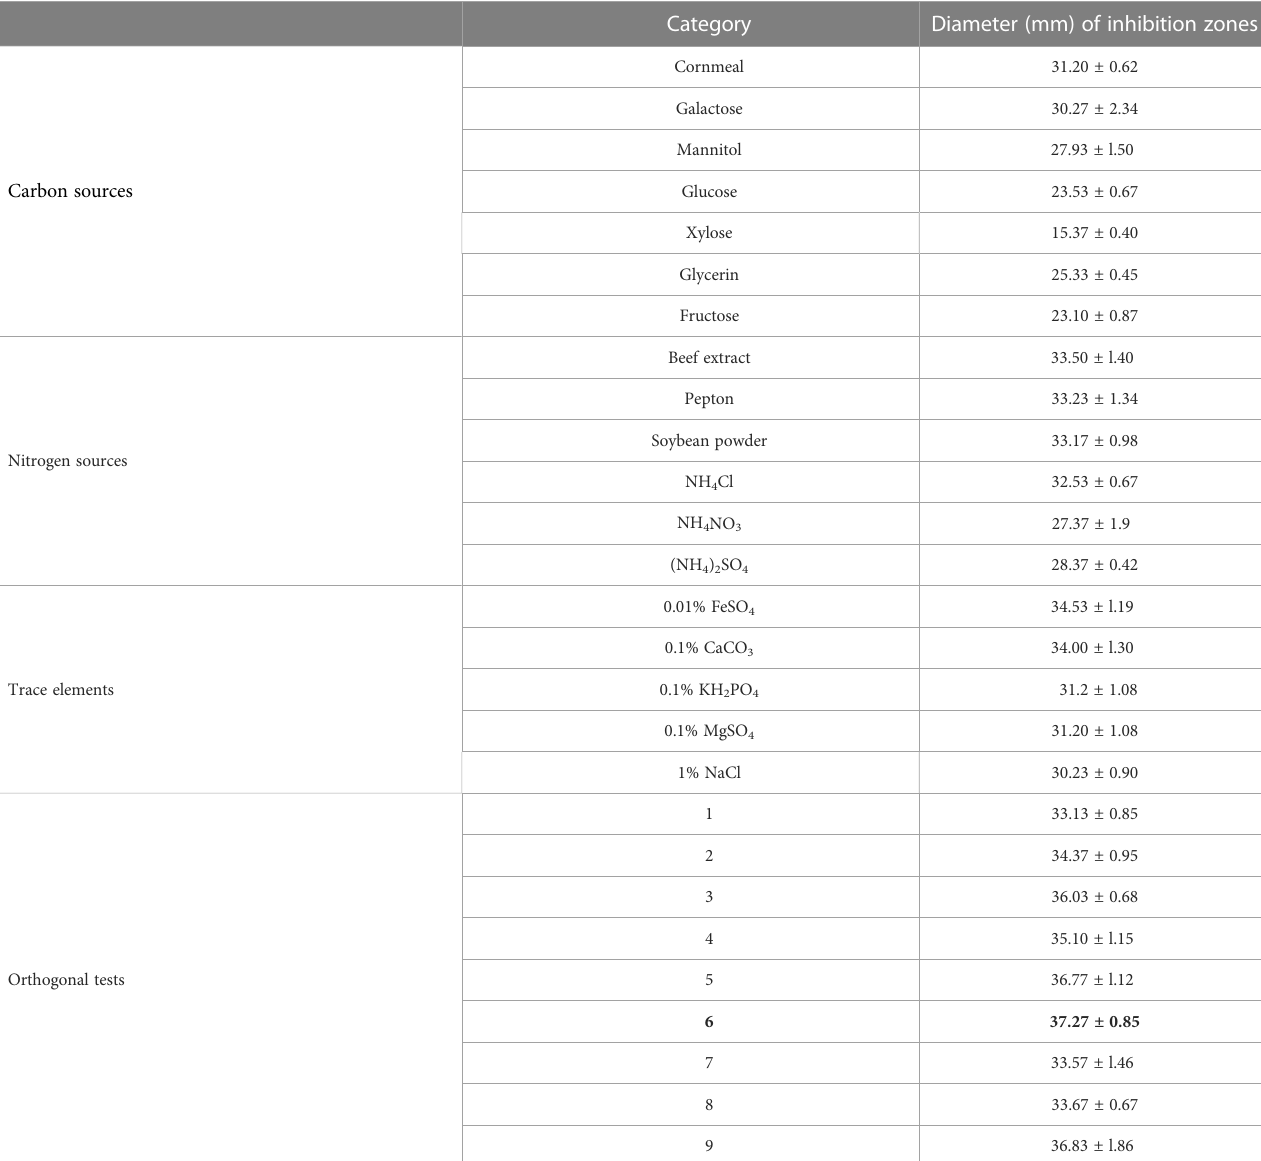
TABLE 1 Culture conditions and shaking fl ask fermentation